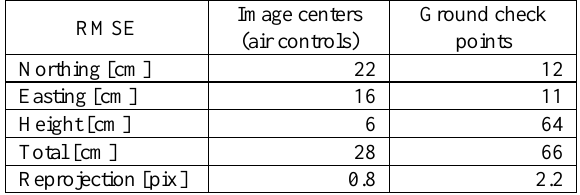
Table 1. Accuracy of bundle adjustment using air controls